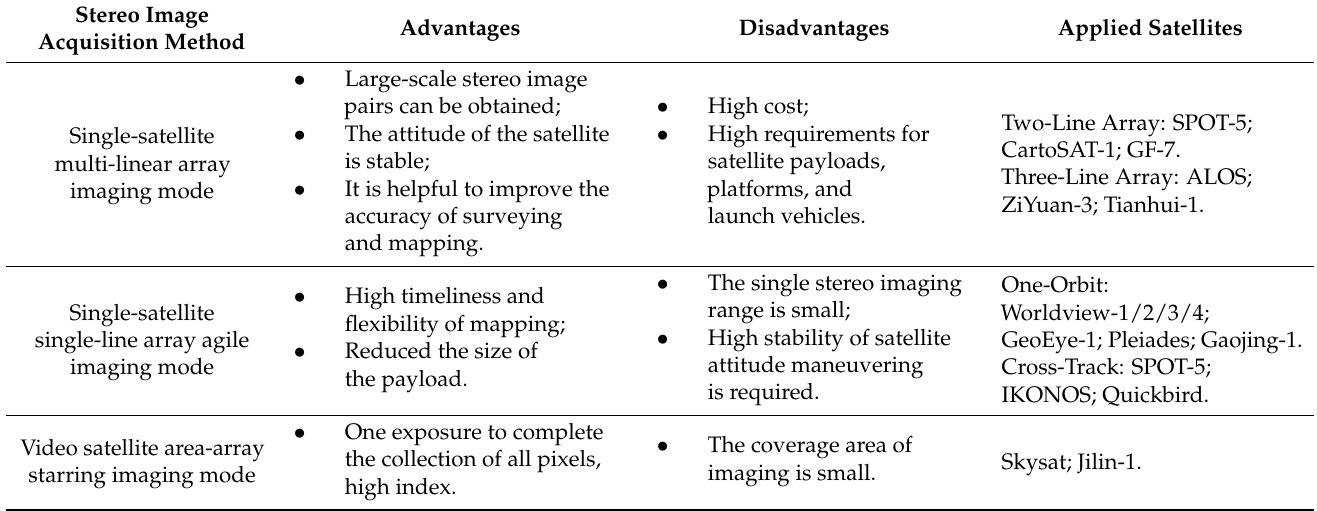
Table 1. Stereo image acquisition